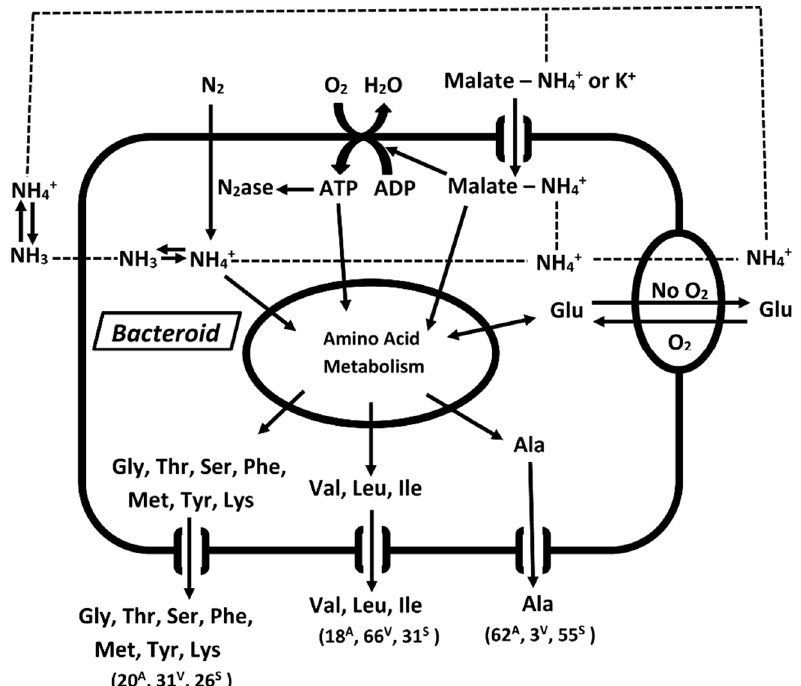
Figure 10. Model of ex planta B . diazoefficiens bacteroid nitrogen compound transport. The three sets of amino acid transporters do not represent specific transporters but rather groupings of amino acids to demonstrate the variations in amounts of amino acids released under three sets of conditions: conditions for optimal alanine excretion, optimal valine excretion and optimal serine excretion (Figure 6). The values in parenthesis are the molar% of indicated compound(s) relative to the total of all amino acids released under each condition. The superscripts indicate the optimal conditions for alanine (A), valine (V) and serine (S). Individual values for each amino acid are given in the text describing Figure 6. Ammonia may diffuse from the bacteroid and ammonium taken up via other transporters (dotted lines).